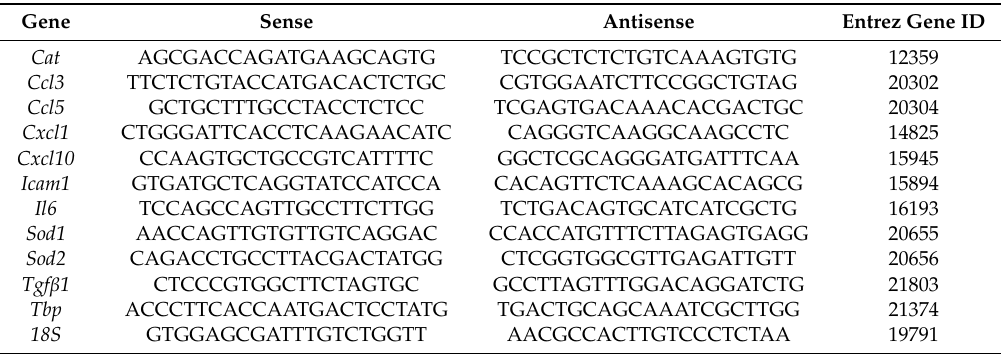
Table 2. Primers used in the real-time PCR